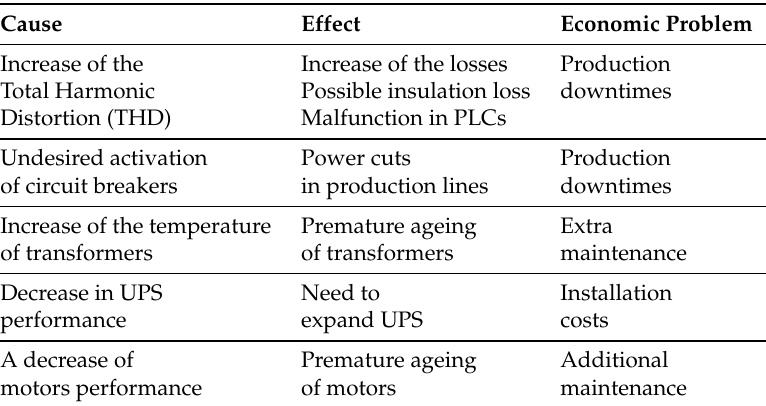
Table 1. Problems caused by harmonics.